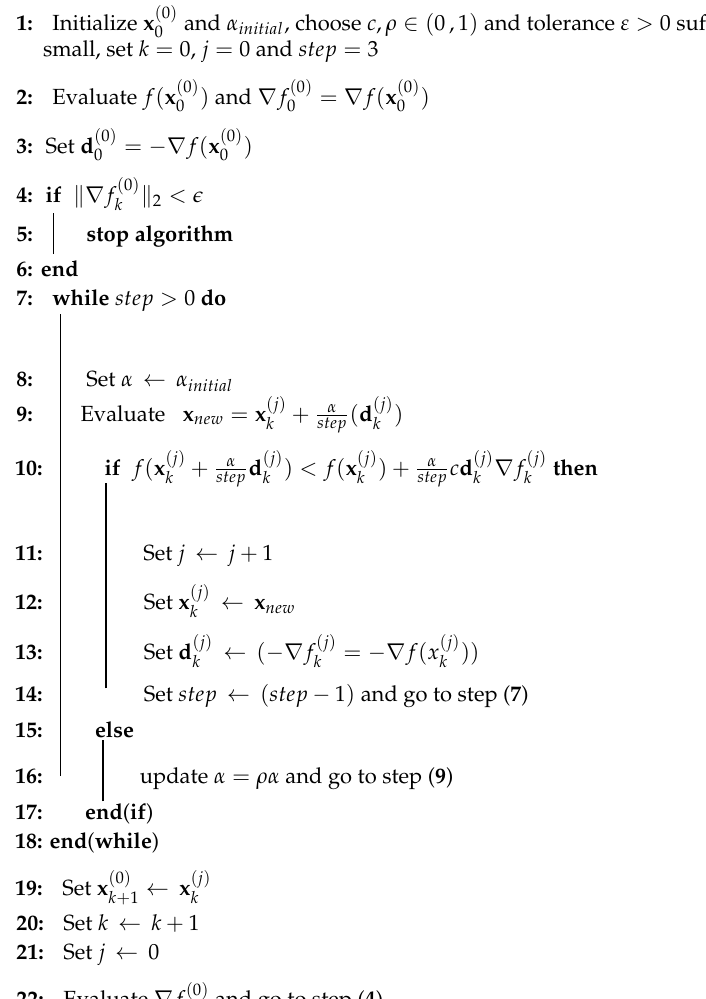
Algorithm 1 Pseudo-code of the three-step discretization